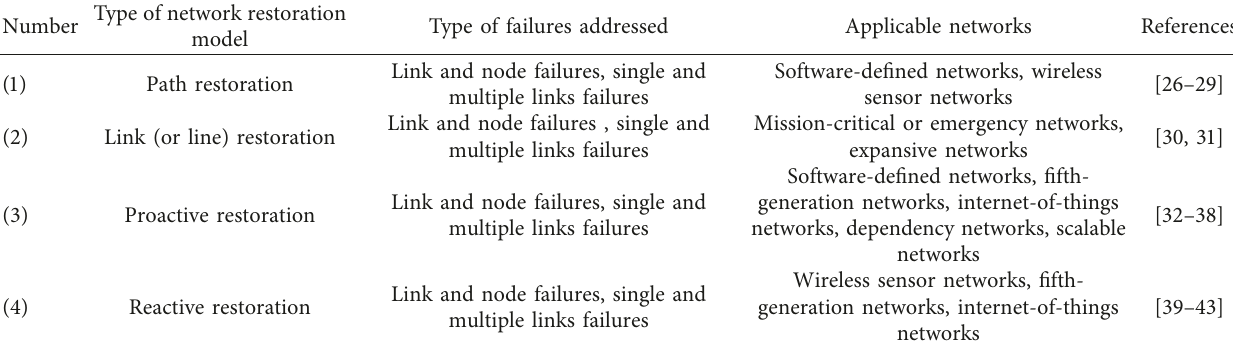
Table 2: Summary of network restoration models employed in emerging xG communication and computing